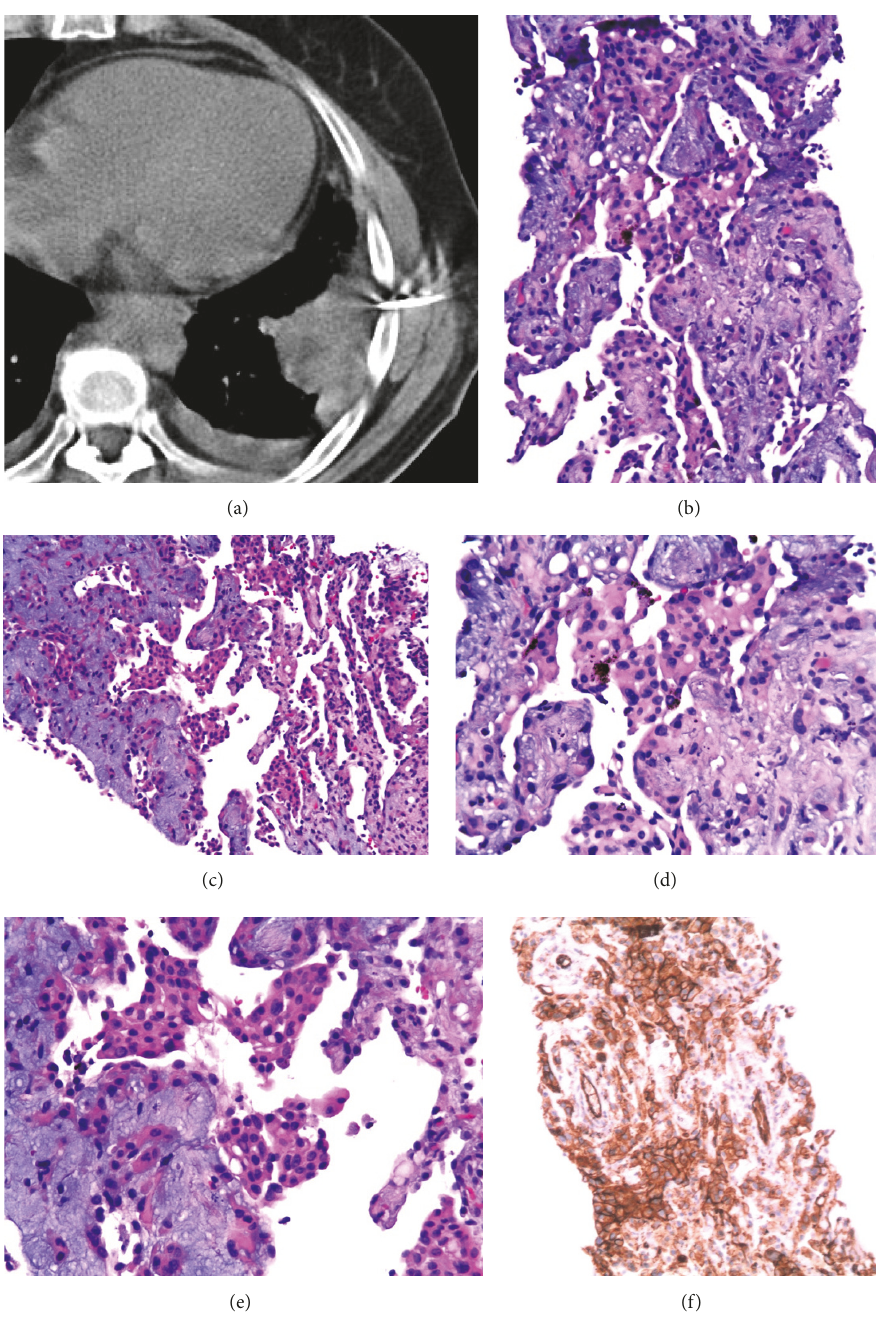
Figure 9: 20 G Tru-Cut biopsy of the lung mass (a). H-E (b–e) images show vascular proliferation with epithelioid cells in a fibromyxoid stroma and presence of haemosiderophages ((b, c) 10x; (d) 20x). Some of the epithelioid cells show vacuolation (e). Immunostaining for CD31 revealed positivity of the neoplastic cells (brown colour), confirming the endothelial lineage of the